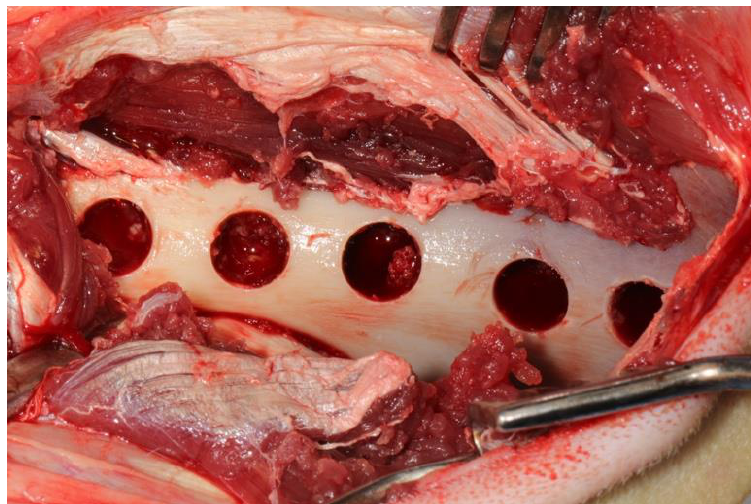
Figure 2. View of surgically created defects.